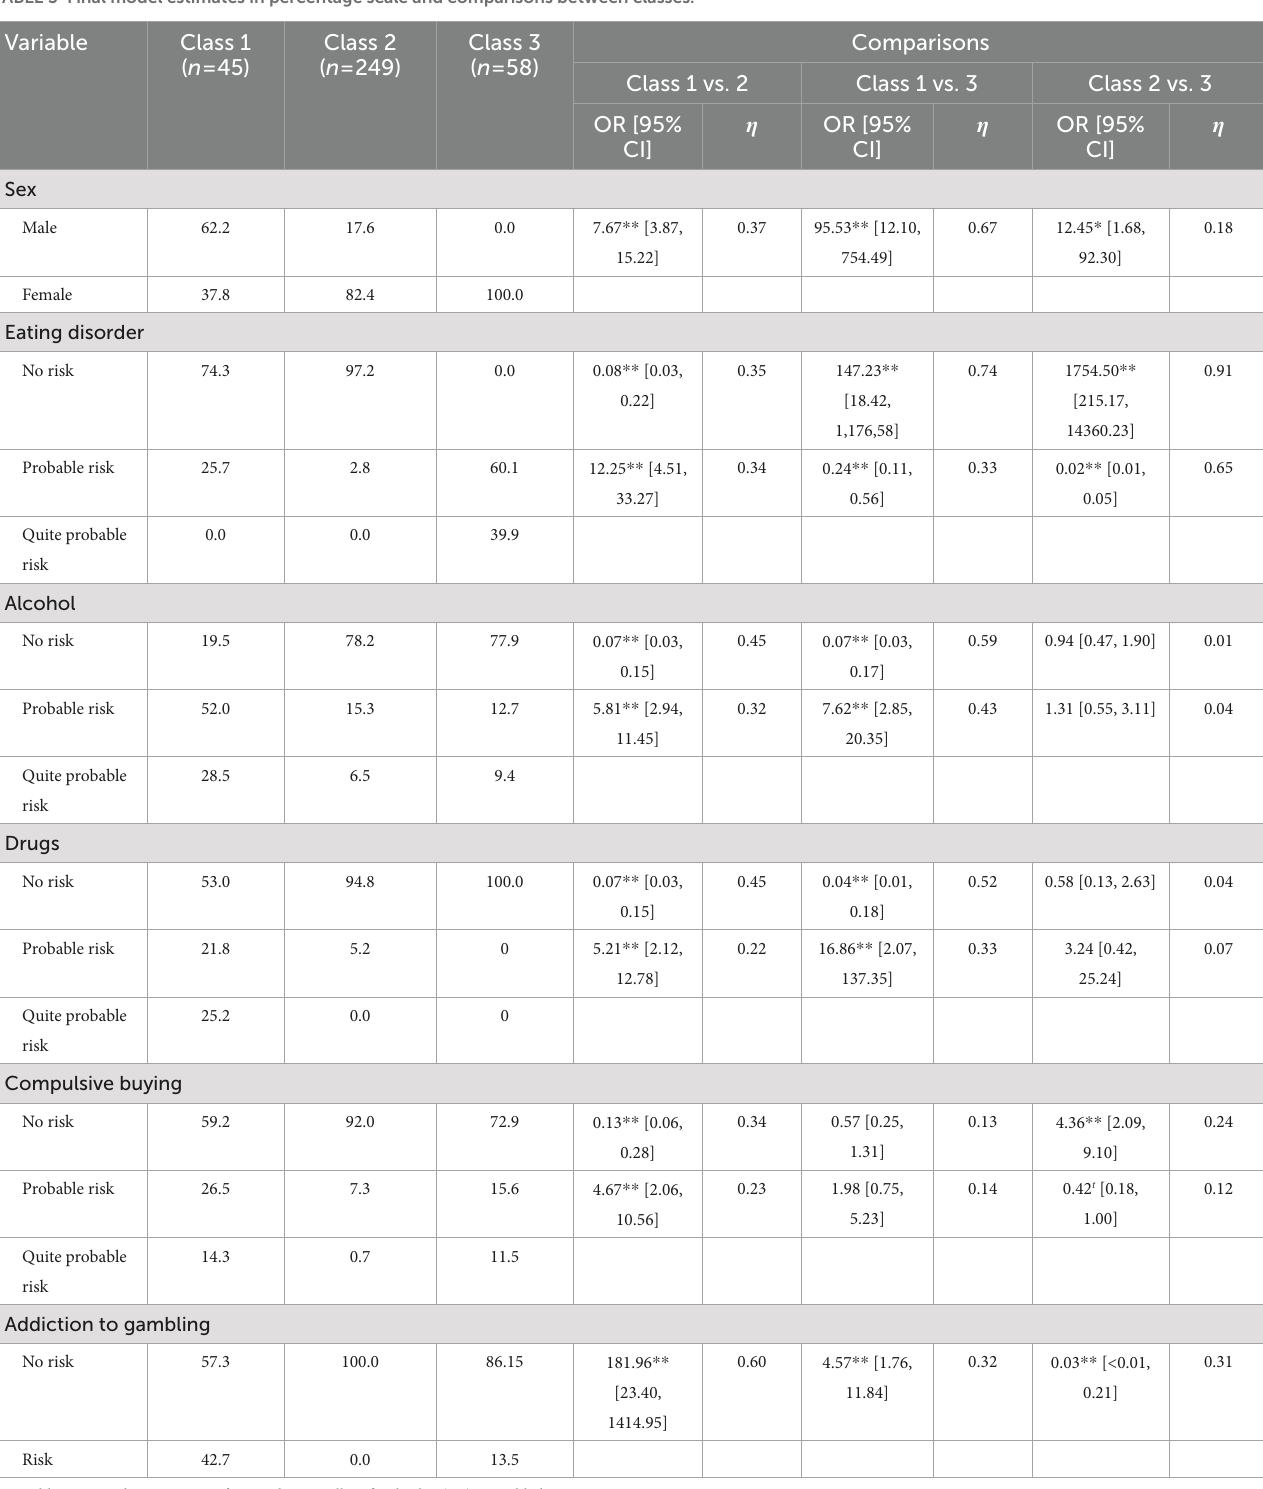
TABLE 3 Final model estimates in percentage scale and comparisons between